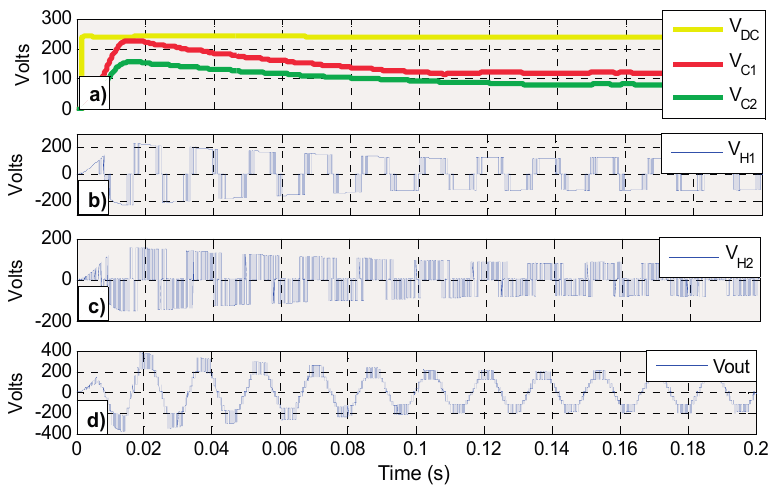
Figure 10. Main voltage waveforms ( a ) V DC , V C 1 , and V C 2 ; ( b ) V H 1 ; ( c ) V H 2 ; and ( d ) V out .